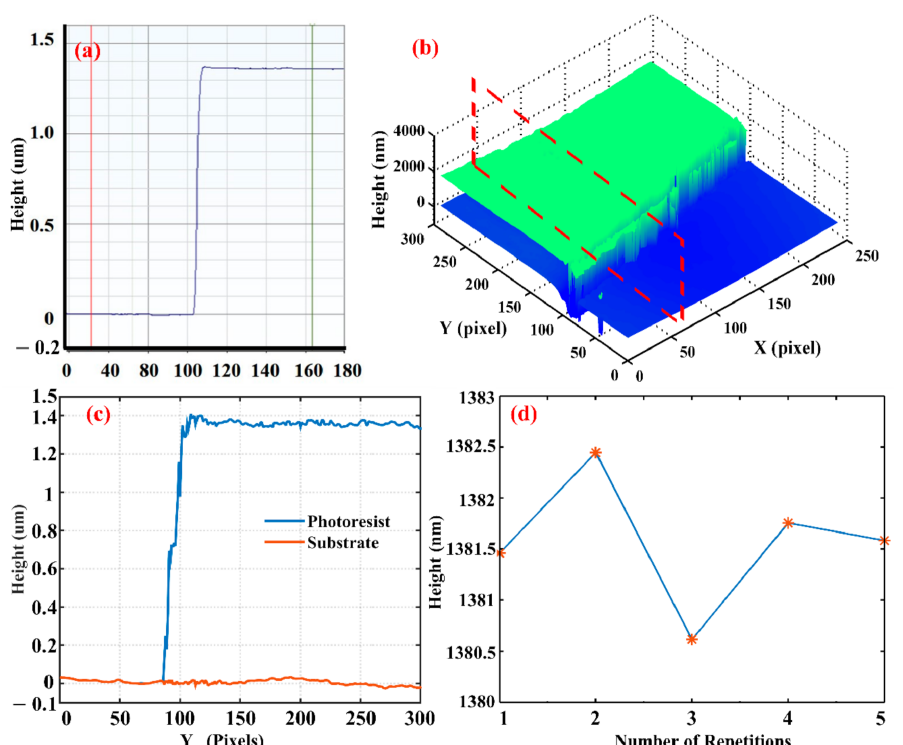
Figure 9. ( a ) The measurement by the commercial stylus Profilometer. ( b ) The 3D reconstruction of the partial sample by the IPS-SIM, where the pixels range from 101 to 400 at the x -axis and from 51 to 300 at the y -axis. ( c ) The cross-section profile at X = 70 of Figure 9b. ( d ) The repeatability measurement at the same point by the